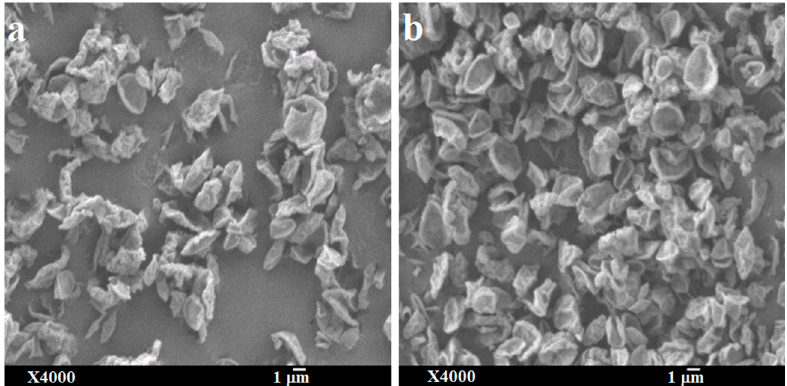
Figure 8. Scanning electron micrographs of spray-dried bedaquiline with 20% w/w of L -leucine powder after one month’s storage at two different conditions: a ) at 30 ± 2% RH and ambient room temperature (in desiccator) and b ) at 75 ± 2% RH and 25 ± 2 °C (elevated condition).